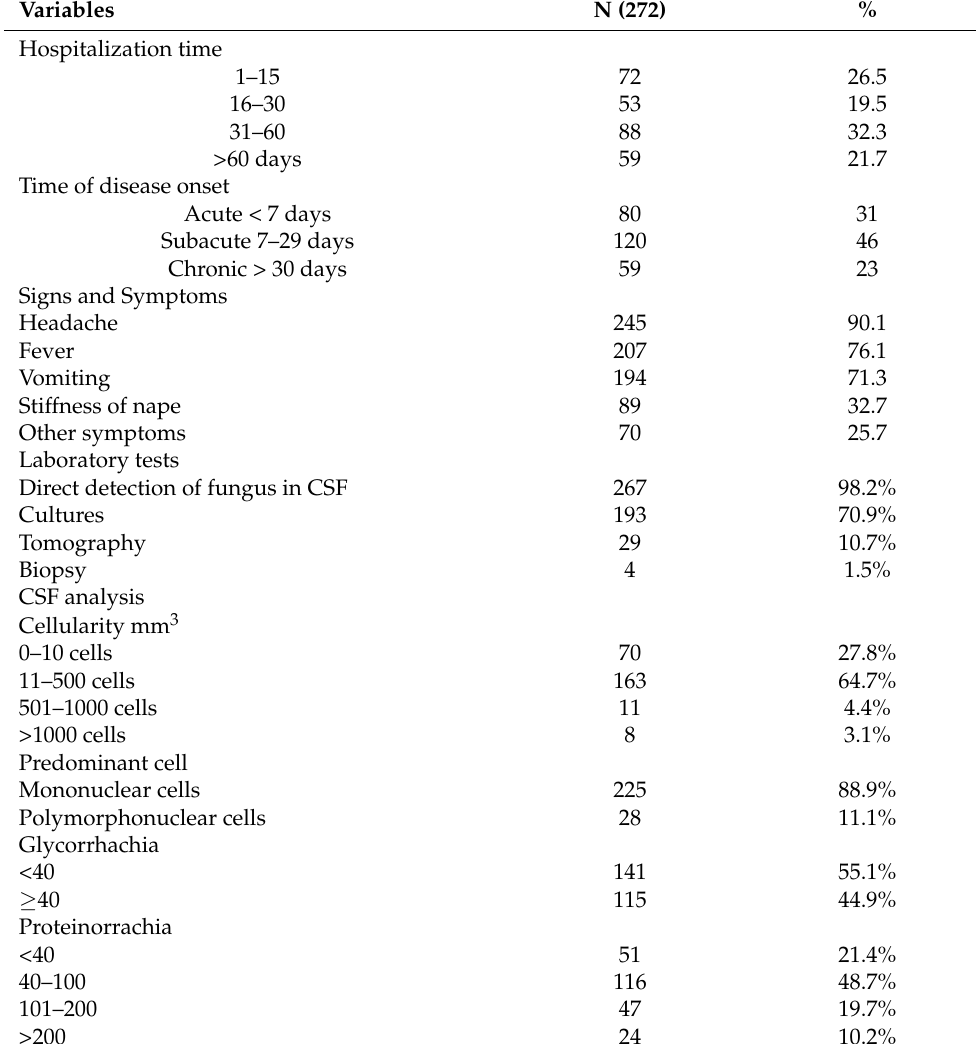
Table 2. Clinical and laboratory profile of patients with cryptococcosis, 2008–2018, JBBUH, Par á ,